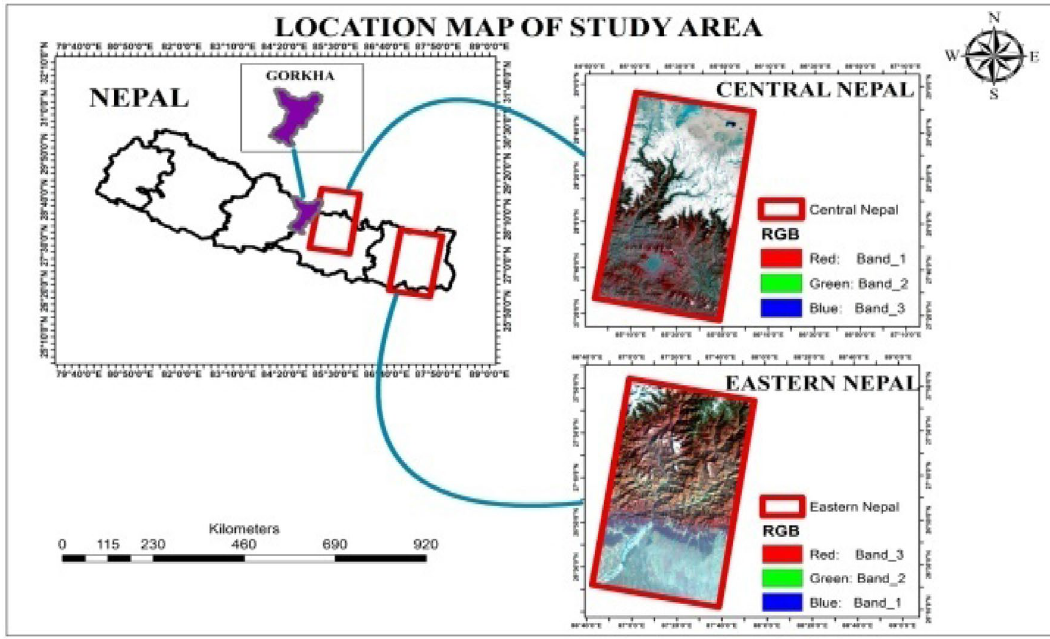
Fig. 1 Location map of study